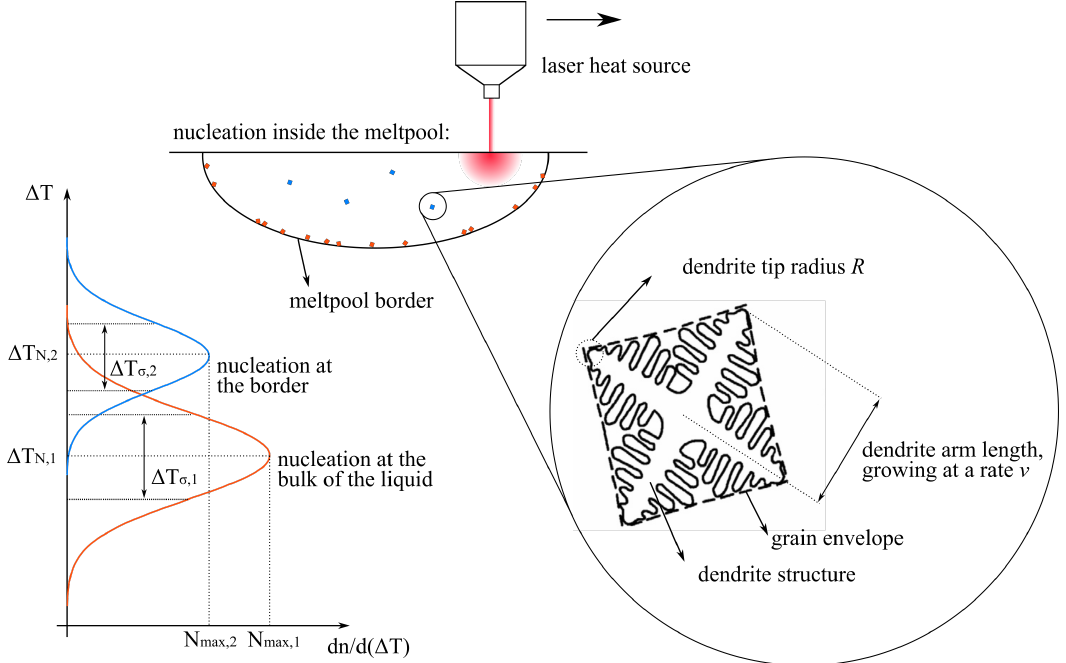
Figure 5. Separate Gaussian distributions for nucleation density in the bulk of the liquid and on the meltpool borders, a schematic representation of nuclei distribution in the meltpool and a zoom into an individual growing